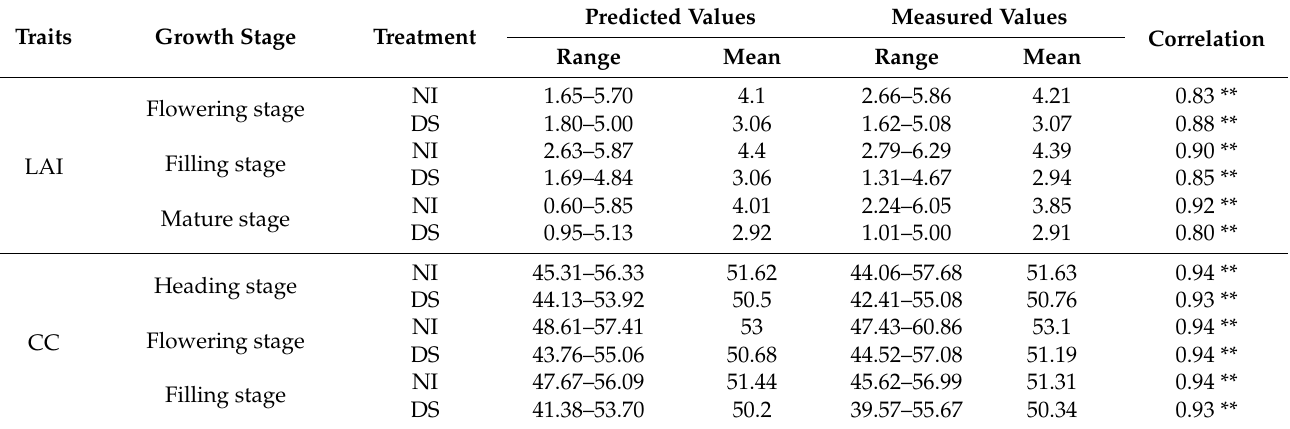
Table 5. Correlation analysis between measured and predicted values for leaf area index (LAI) and chlorophyll content (CC) of 309 recombinant inbreeding lines (RILs) from wheat cross Worrakatta ×